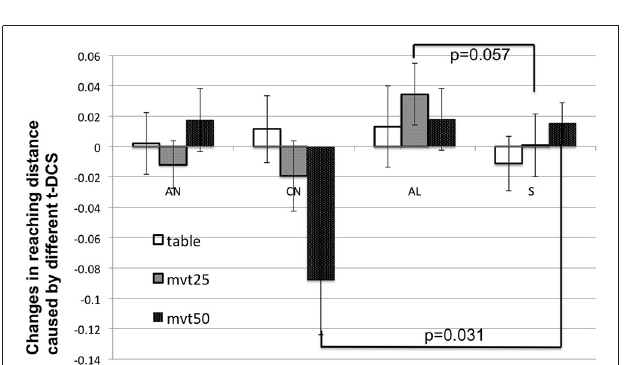
FIGURE 4 | The cross-subject mean and standard error of reaching distance pre (open bars) and post c-tDCS (shaded bars) over non-lesioned M1 area .